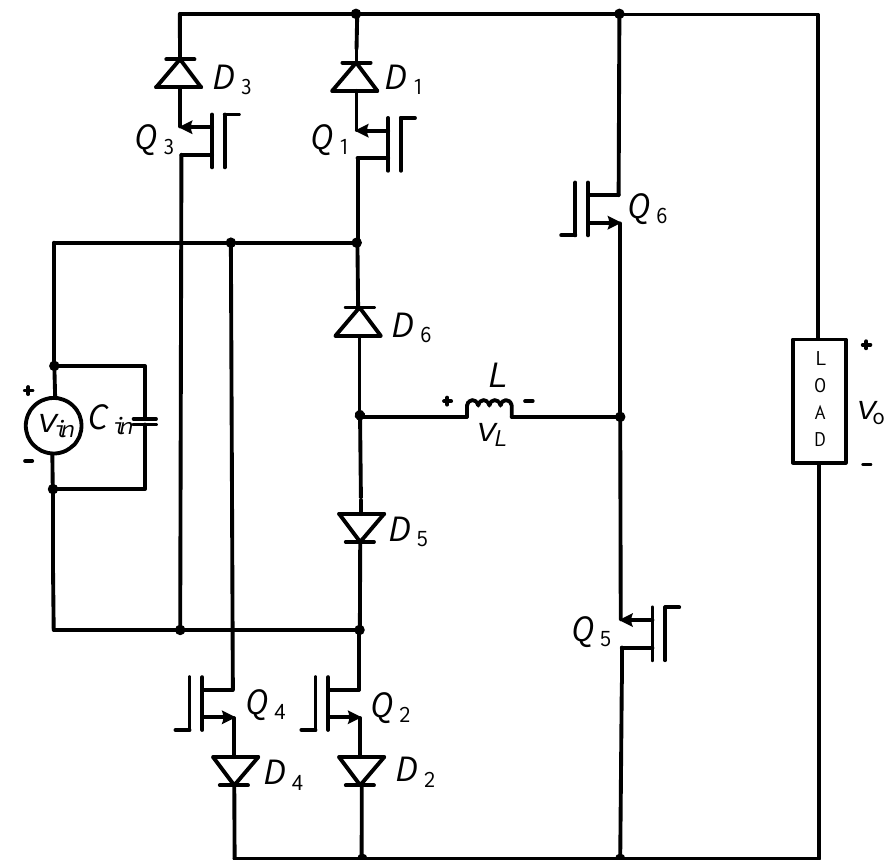
Figure 2. Schematic view of the suggested topology.